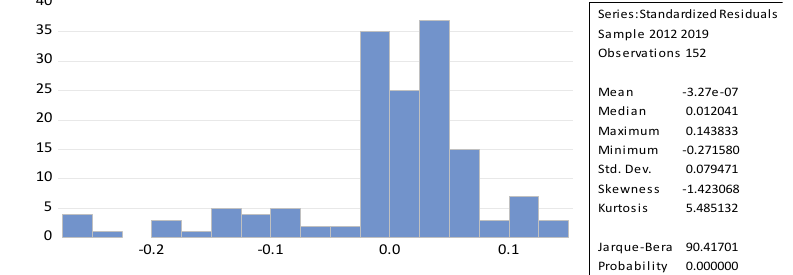
Figure 2. The normality of error terms in the first hypothesis.